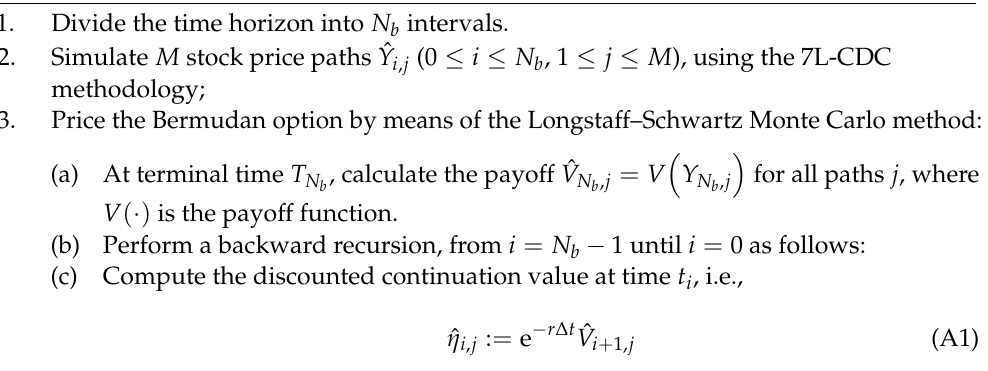
Algorithm A1: 7L Scheme Longstaff–Schwartz